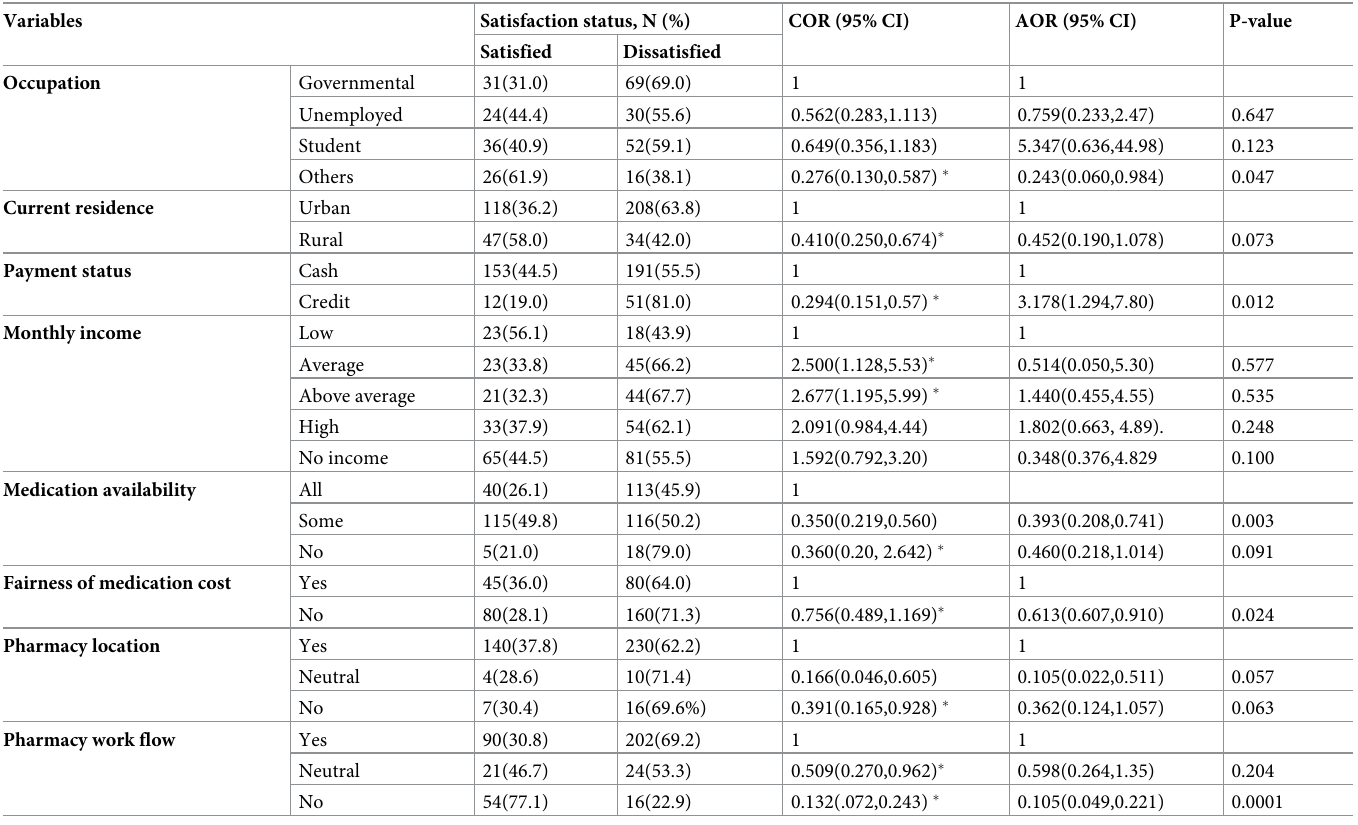
Table 3. Multivariable logistic regression analysis of factors at Dupti General Hospital, Afar, Ethiopia,